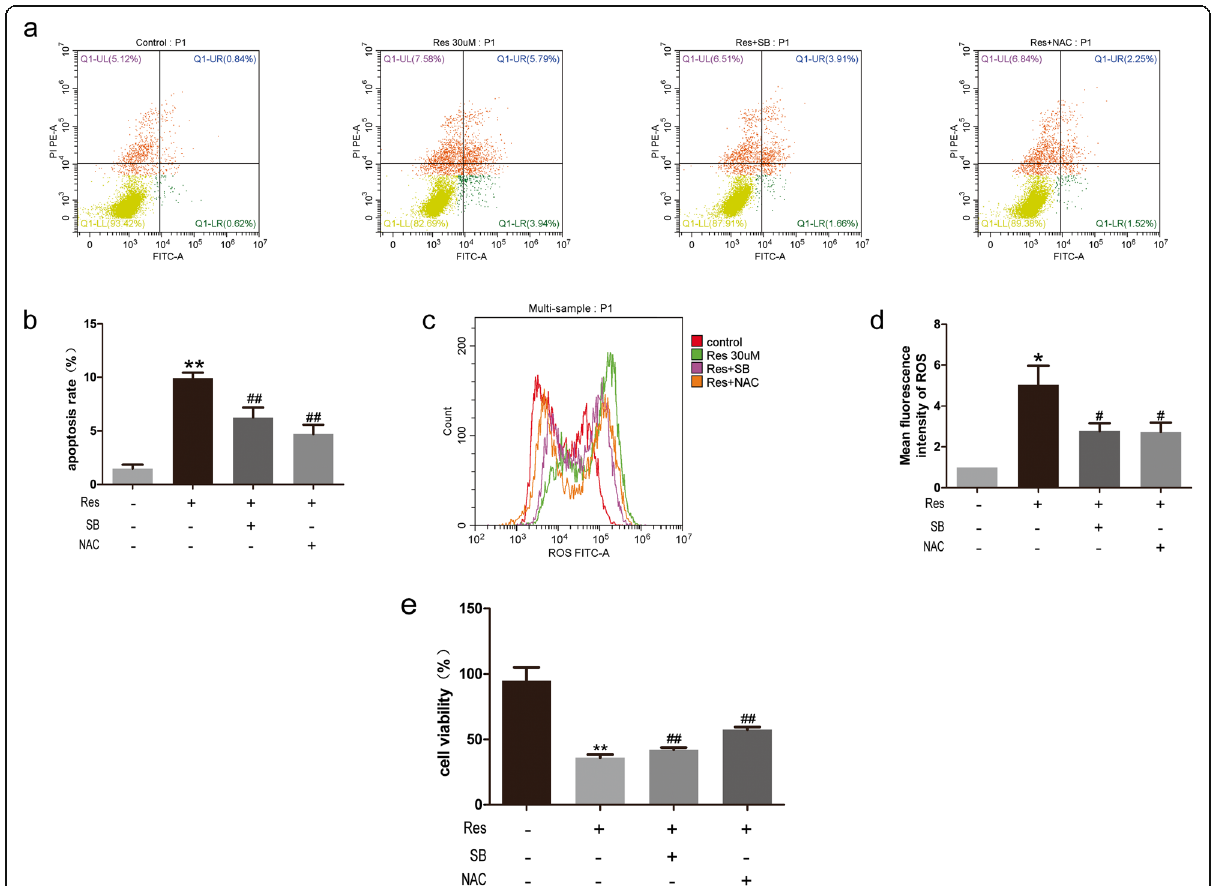
Fig. 3 SB203580 or NAC relieved the resveratrol induced growth inhibition, apoptosis and ROS accumulation. a, b Flow cytometry analysis of apoptosis. c, d Measurement of ROS production by flow cytometry. e MTT assay after treatment. SB and NAC are the abbreviation of SB203580 and N-Acetyl-L-cysteine, BPH-1 was treated with 30 μ M Res, 30 μ M Res plus 5 μ M SB and 30 μ M Res plus 5 mM NAC. student ’ s t -test was used to analysis the data, *P < 0.05,**P < 0.01 (compared with vehicle-treated control), #P < 0.05, ##P < 0.01 (compared with Res 30 μ M